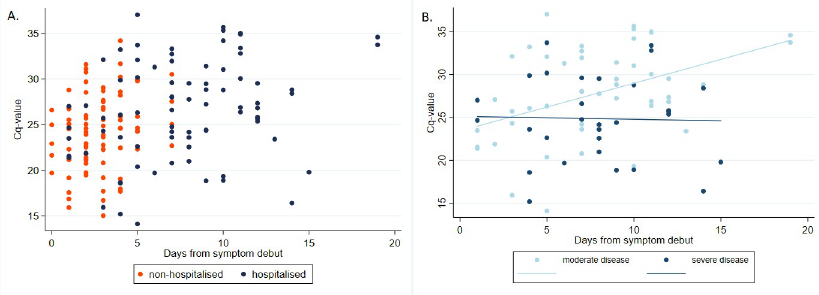
Fig 3. SARS-CoV-2 PCR baseline C q -values and days from symptom debut to baseline sample in non-hospitalised (n = 87, in orange) and hospitalised (n = 82, in blue) patients with COVID-19 disease ( a ), and of the admitted patients with moderate (n = 51, light blue) and severe (n = 31, dark blue) disease ( b ).